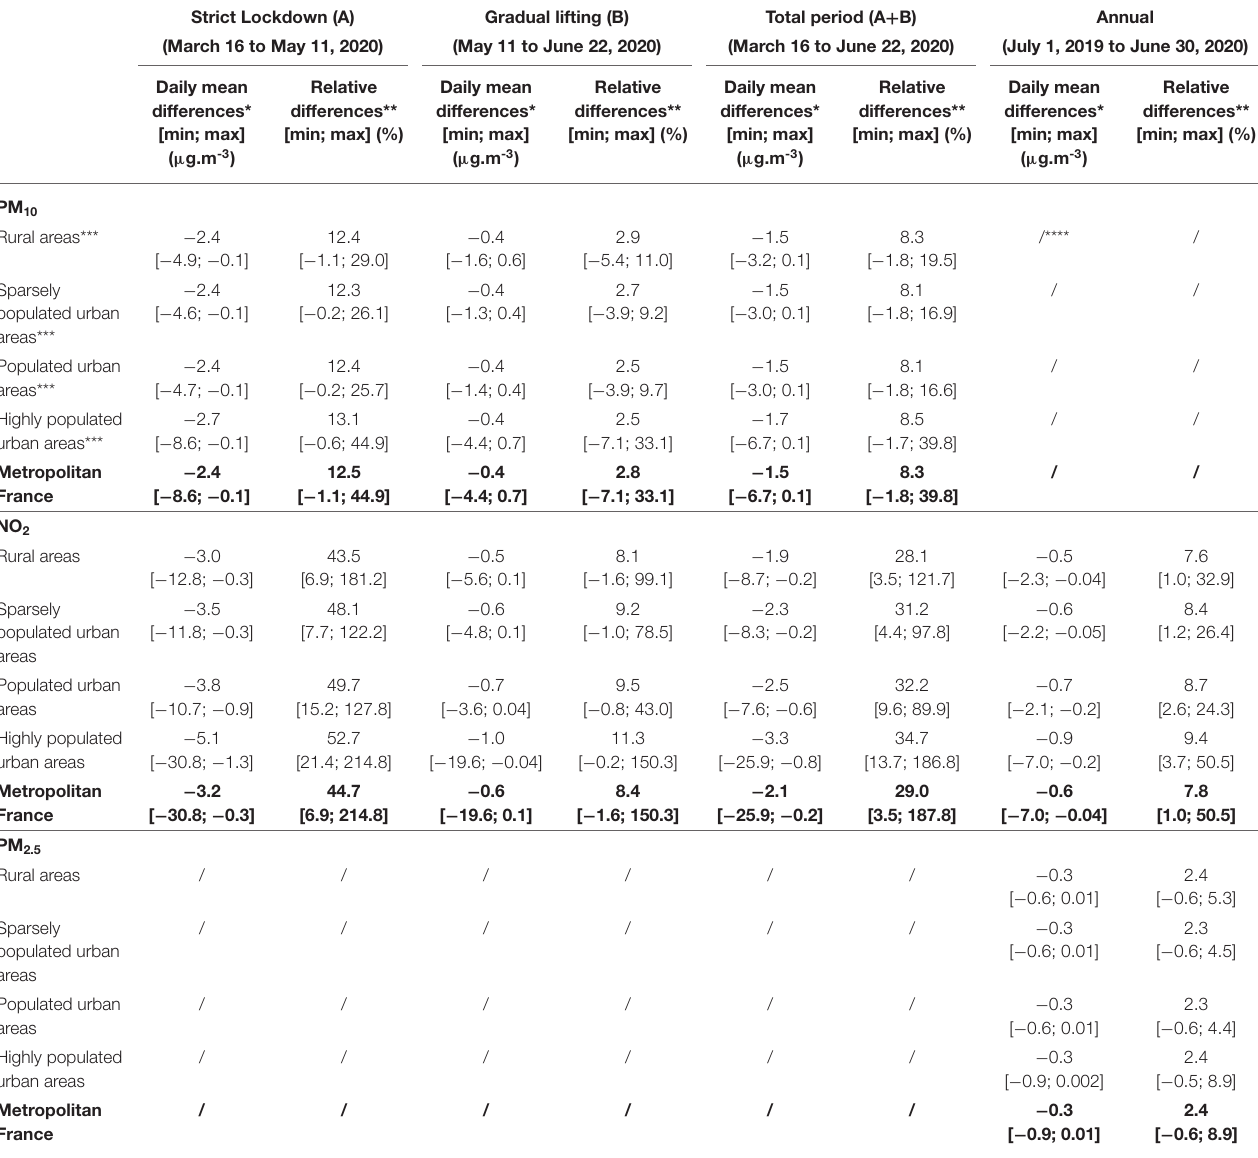
TABLE 2 | Daily mean differences [min; max] by period, pollutant and area in France from March 16 to June 22, 2020, and from July 1, 2019 to June 30,